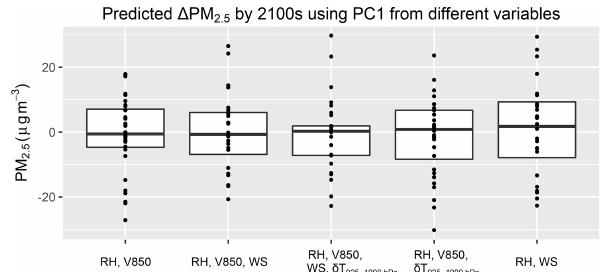
Figure 6. Same as Fig. 5c, but using PC1s constructed from five different combinations of meteorological variables as listed in Ta- ble S1. We do not include the two PC1s that use δ U500 (experiment no. 3 and no. 6 in Table S1). See text for more